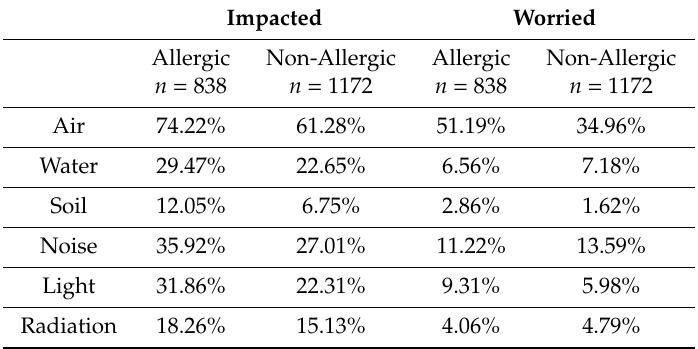
Figure 3. Skin discomforts associated with skincare products in the two populations. Table 5. Impact of pollution in the two